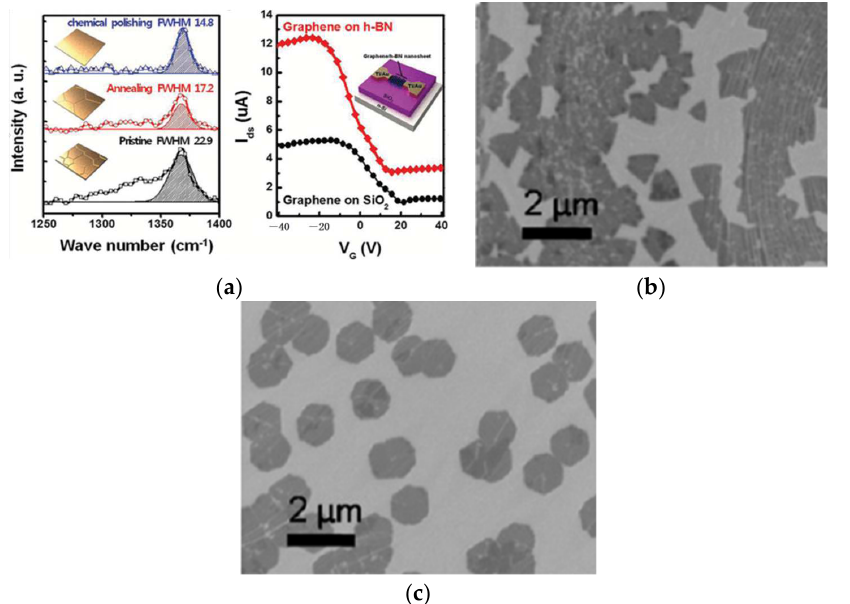
Figure 14. ( a ) Raman spectra of h-BN nanosheets grown on individual Cu foils at 514 nm. The inset images reveal the schematic illustrations of the morphology-controlled Cu foils and the I ds –V g characteristics of graphene (GR) TFTs on bare SiO 2 and high-quality h-BN nanosheets in atmospheric ambience [71]. ( b , c ) SEM images of ( a ) triangular and ( b ) hexagonal-shape h-BN domains grown on unpolished and polished Cu, respectively [72].